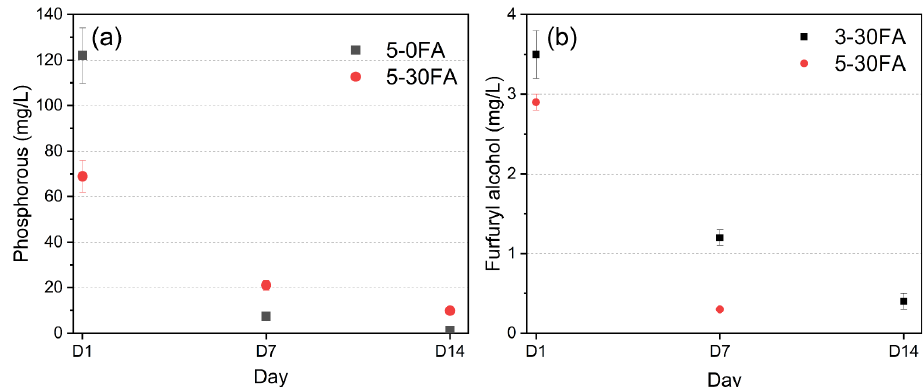
Figure 2. ( a ) Phosphorus concentrations of 5-30FA and 5-0FA in leached water solutions at days 1, 7, and 14. ( b ) Furfuryl alcohol concentrations in the leached water samples from 0-30FA, 3-30FA, and 5-30FA. Day 1, 7, and 14 samples from 0-30FA and day 14 sample from 5-30FA were below the detection limit (<0.1 mg/L).